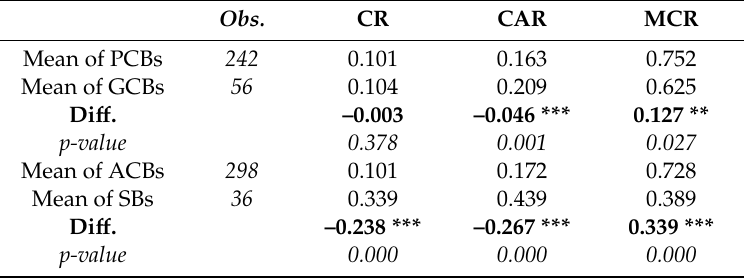
Table 4. Mean comparison.